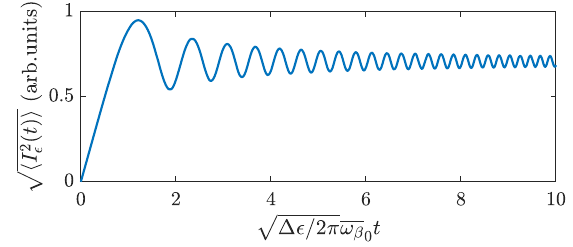
FIG. 2. Depiction of time-dependent amplitude of the second slice according to Eq.